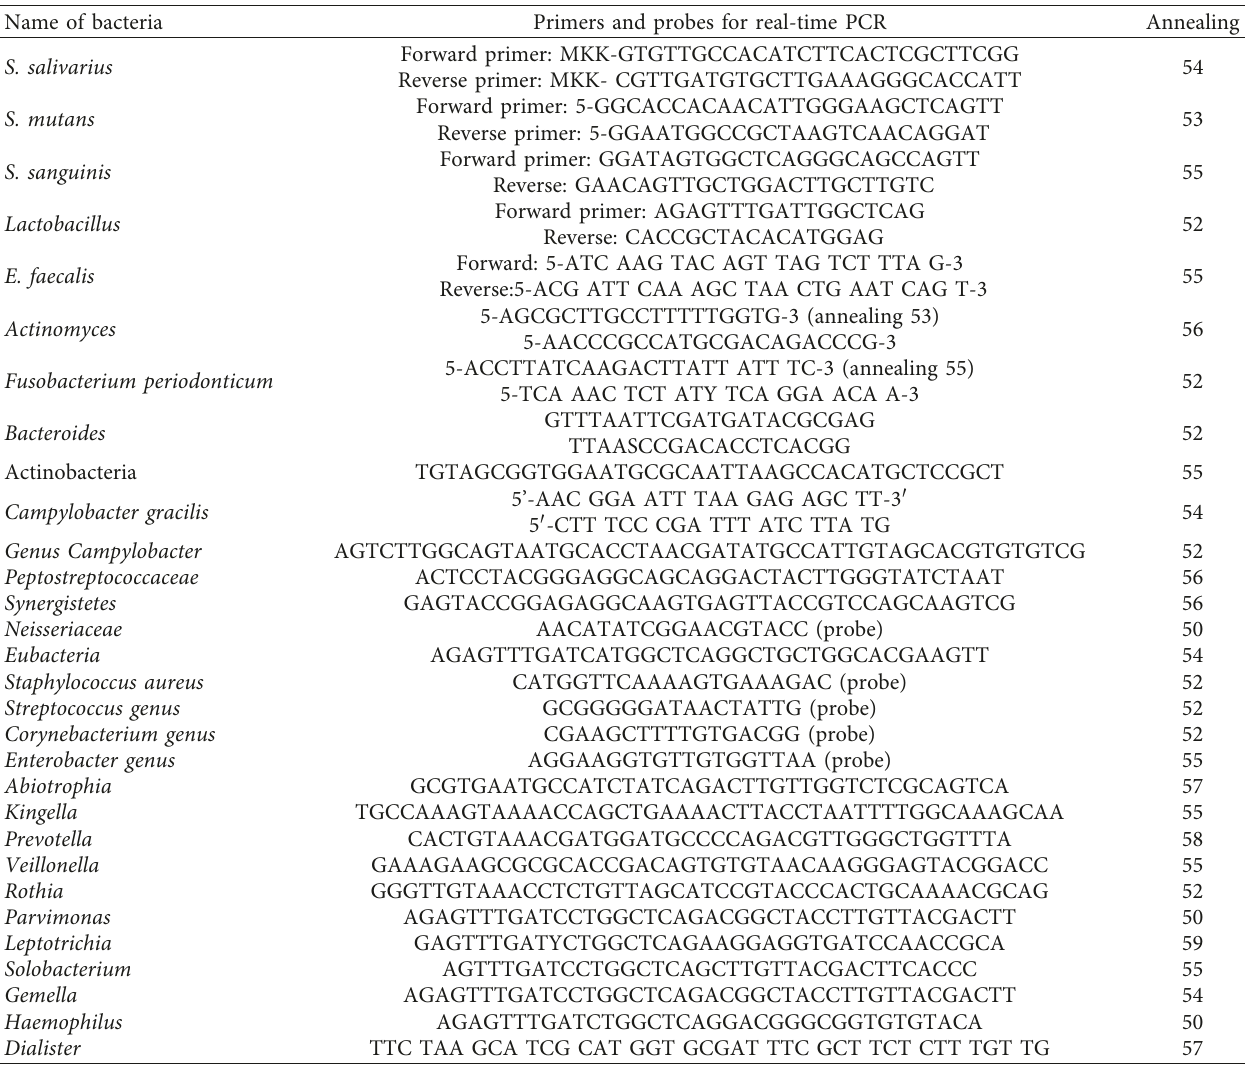
Table 1: Primers and probes for real-time